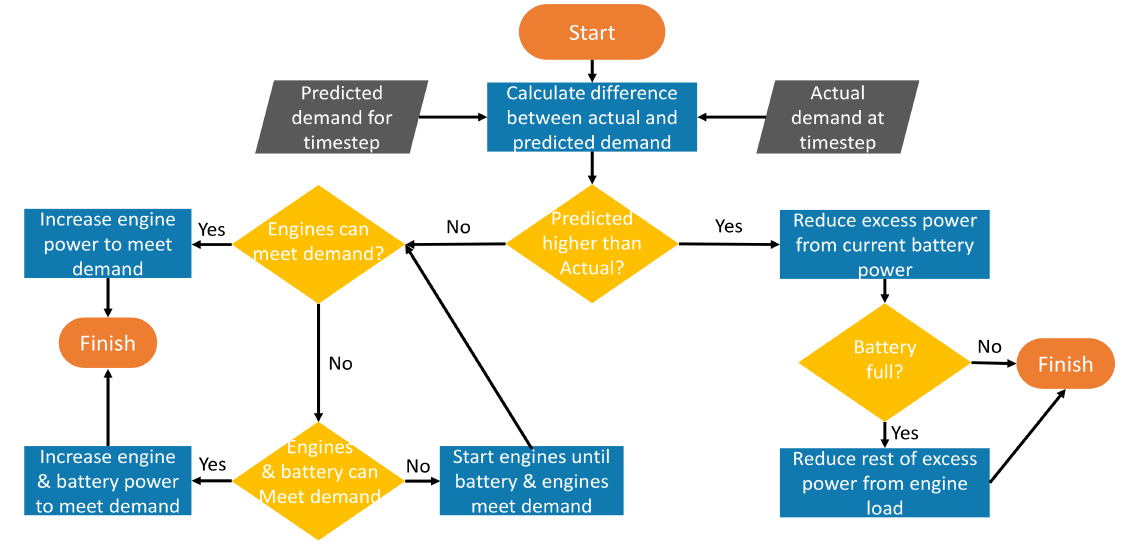
Figure 6. Rule-based system logic.